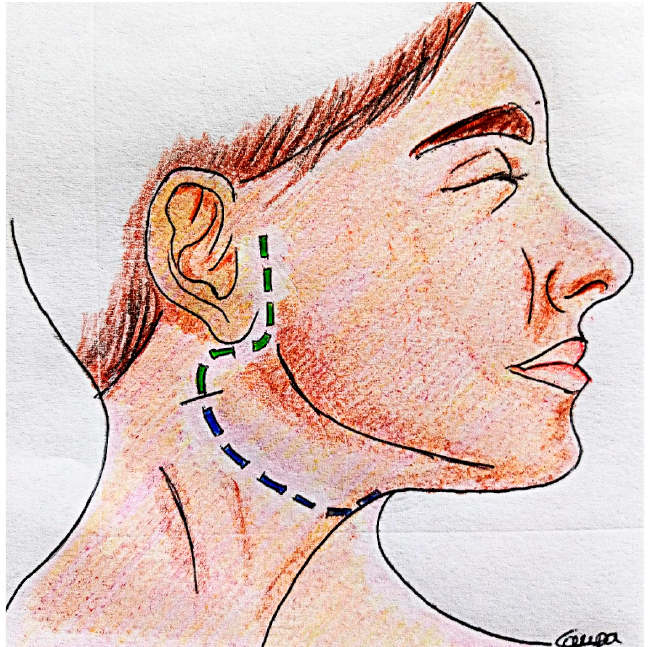
Figure 3. Skin incision for transparothid (green) and cervical (blue) approaches to PS.